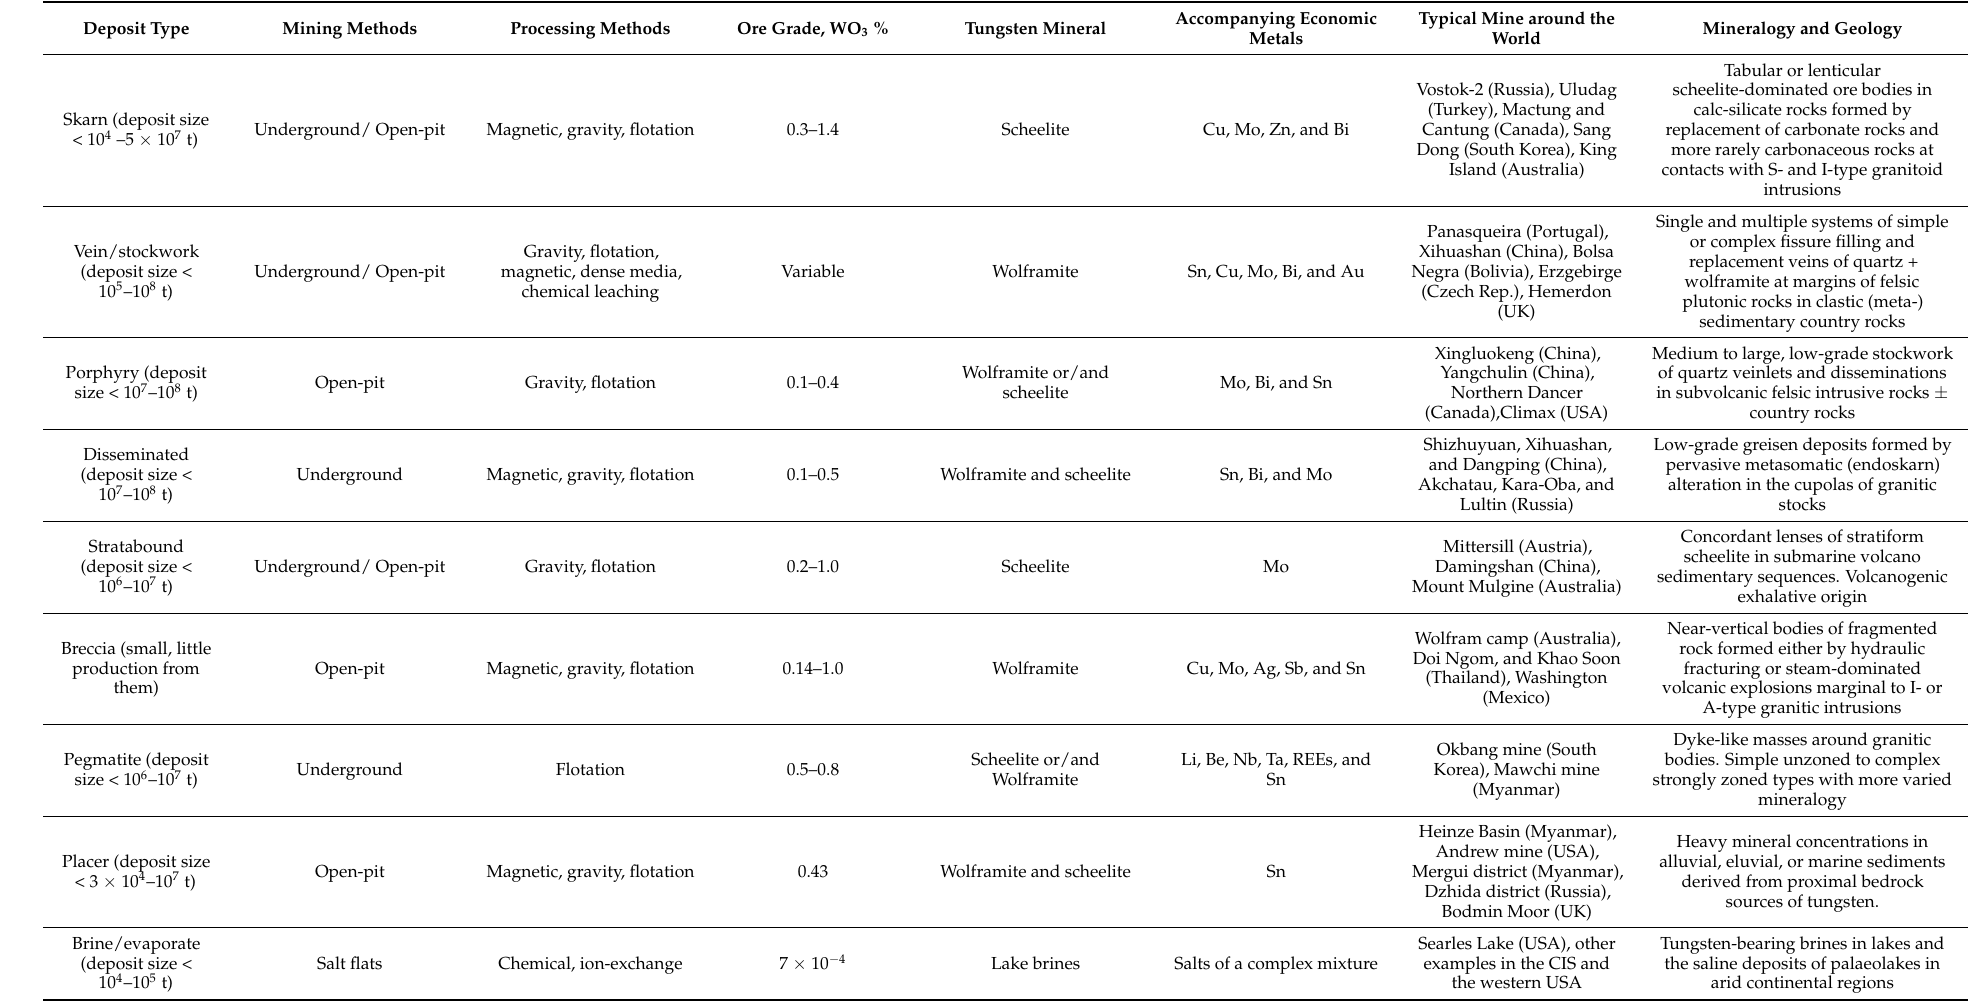
Table 3. Typical tungsten mine parameters worldwide